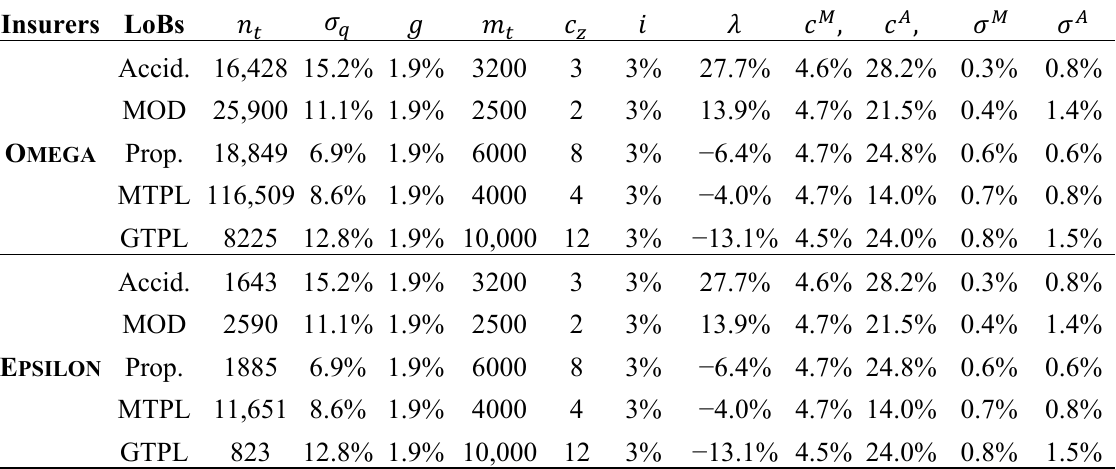
Table 3. Parameters for premium